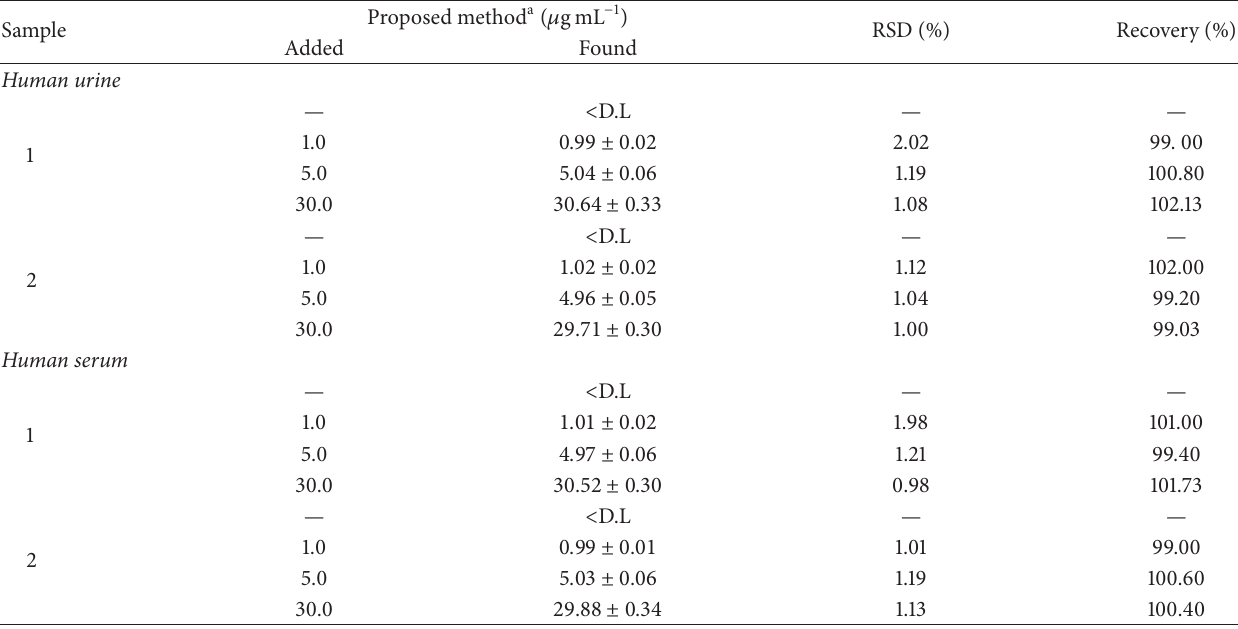
Table 4: Determination of dopamine in human urine and serum samples by the developed